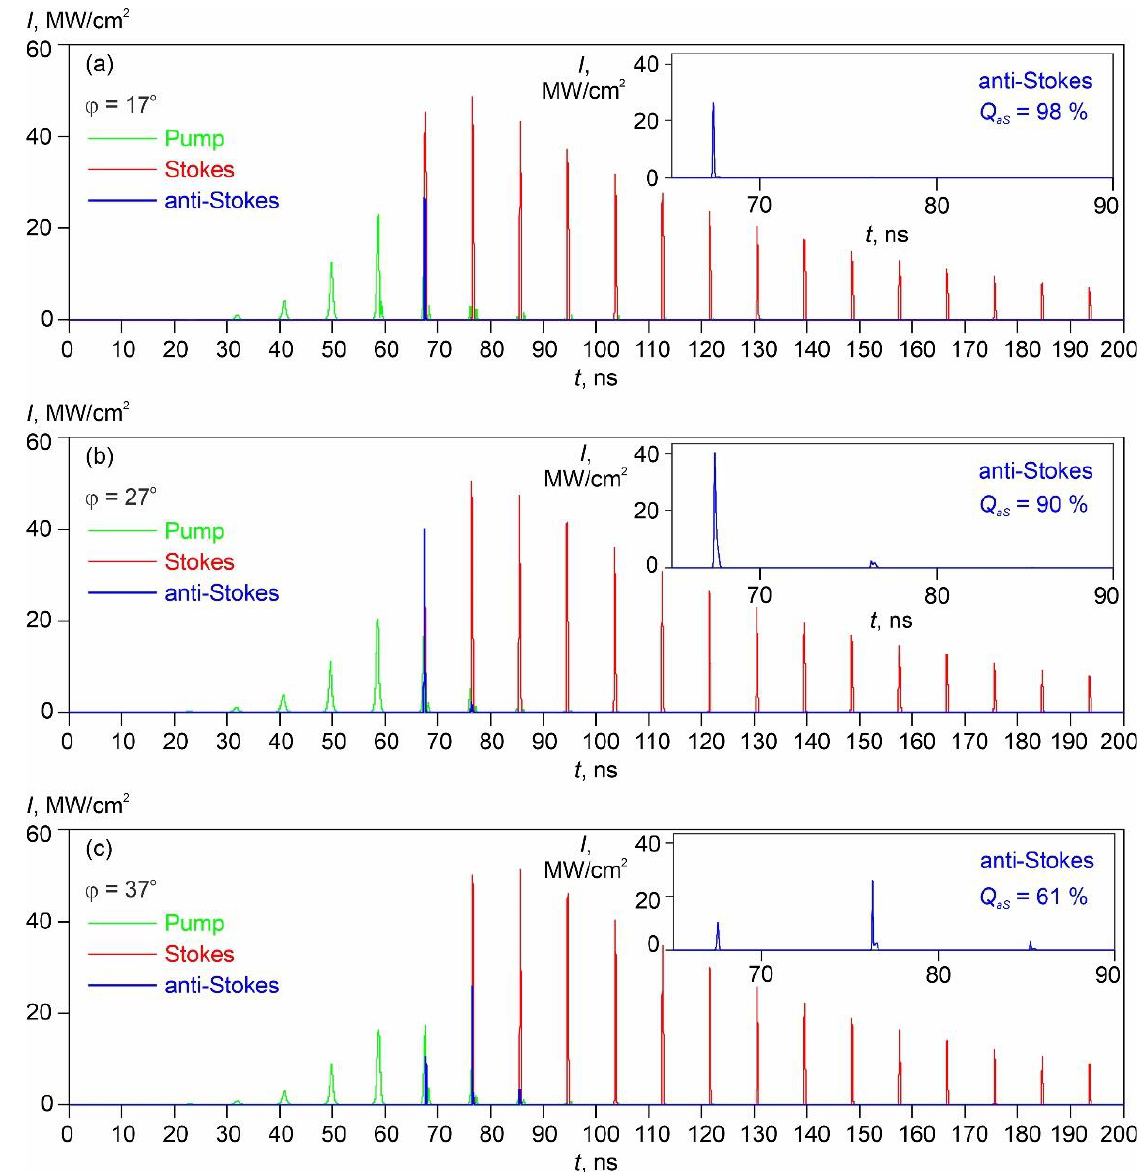
Figure 8. The simulation results of the mode-locked laser oscillation for the shutter with t open = 2 ns at ( a ) φ = 17°, ( b ) φ = 27°, and ( c ) φ = 37°.